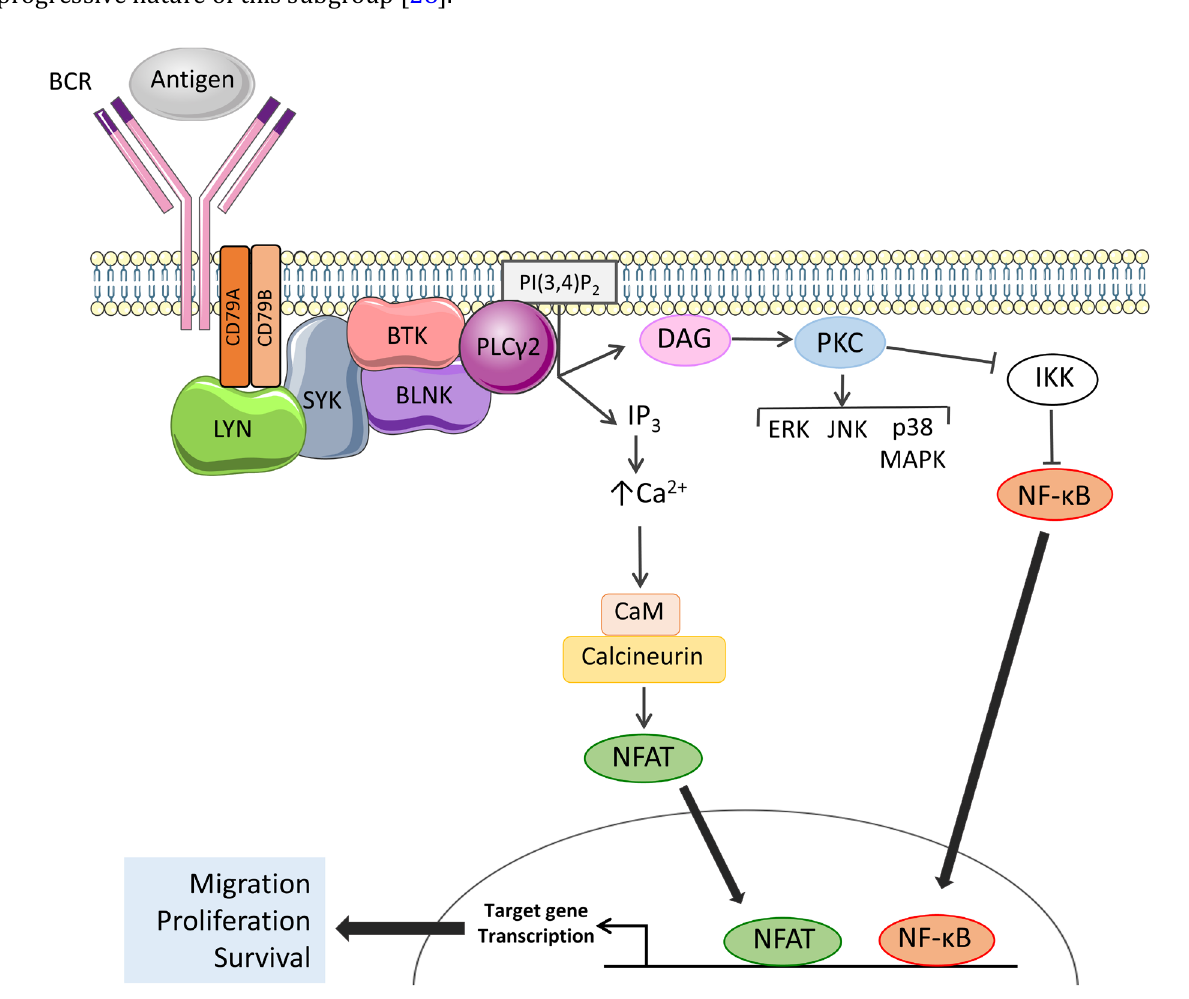
Figure 2. Activation of BTK and PLCγ2 downstream of the BCR. The BCR comprises an antigen-binding immunoglobulin coupled to CD79A and CD79B signal transduction molecules. BCR engagement leads to activation of proximal kinases, such as LYN and SYK. BTK is activated by SYK-mediated phosphorylation and autophosphorylation and, with the scaffold protein BLNK, mediates activation of PLCγ2. Once activated, PLCγ2 cleaves phosphatidylinositol 4,5-bisphosphate (PI(4,5)P inositol 1,4,5-trisphosphate (IP ) and diacylglycerol (DAG), leading to increased intracellular Ca 2+ (iCa 2+ ) and activation of PKC 3 isoforms. Key downstream effects include activation of MAP kinases and Ca 2+ -dependent transcription factors, such as nuclear factor-κB (NF-κB) and, via calmodulin (CaM) and calcineurin, nuclear factor of activated T-cells (NFAT), resulting in increased transcription of genes involved in control of survival, migration and proliferation. Note that not all pathways activated downstream of the BCR are